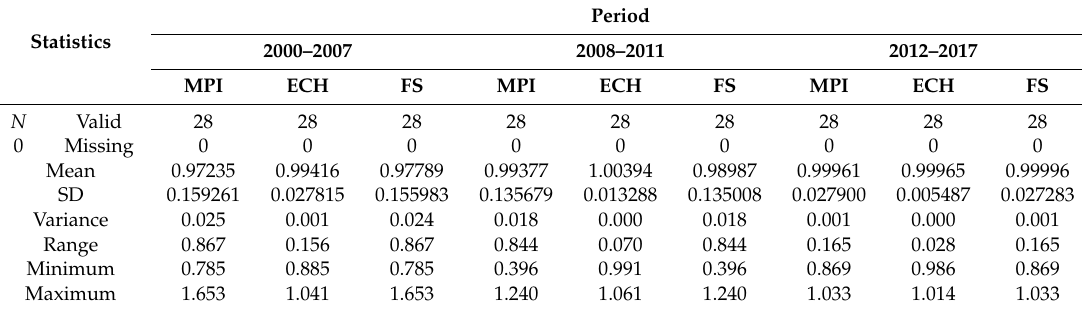
Table 7. MPI descriptive statistics (source: own calculation and elaboration).